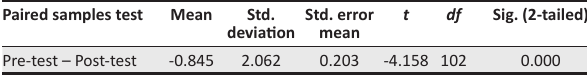
TABLE 3 : Comparison of means between pre- and post-test result (paired sample t -test). Paired samples test